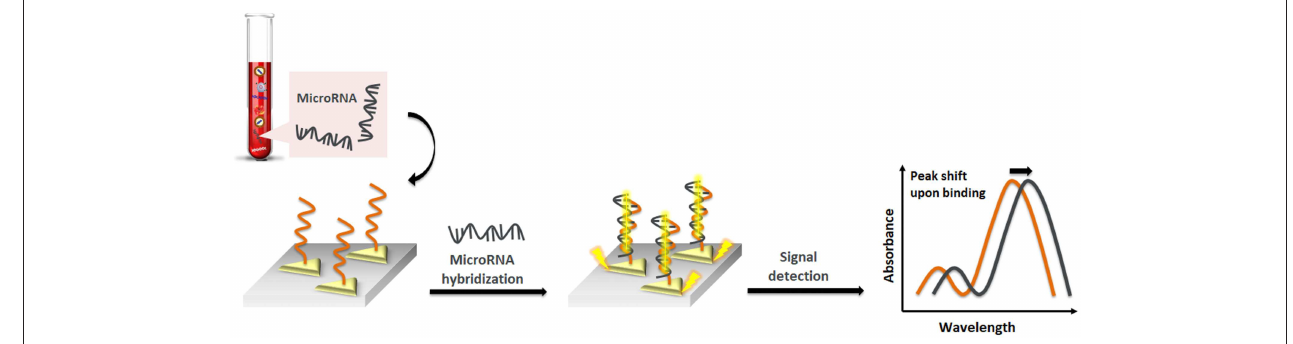
FIGURE 2 | Pictorial description of nanoplasmonic sensors modulating the plasmoelectronic effects at the AuTNP and –S-ssDNA/microRNA